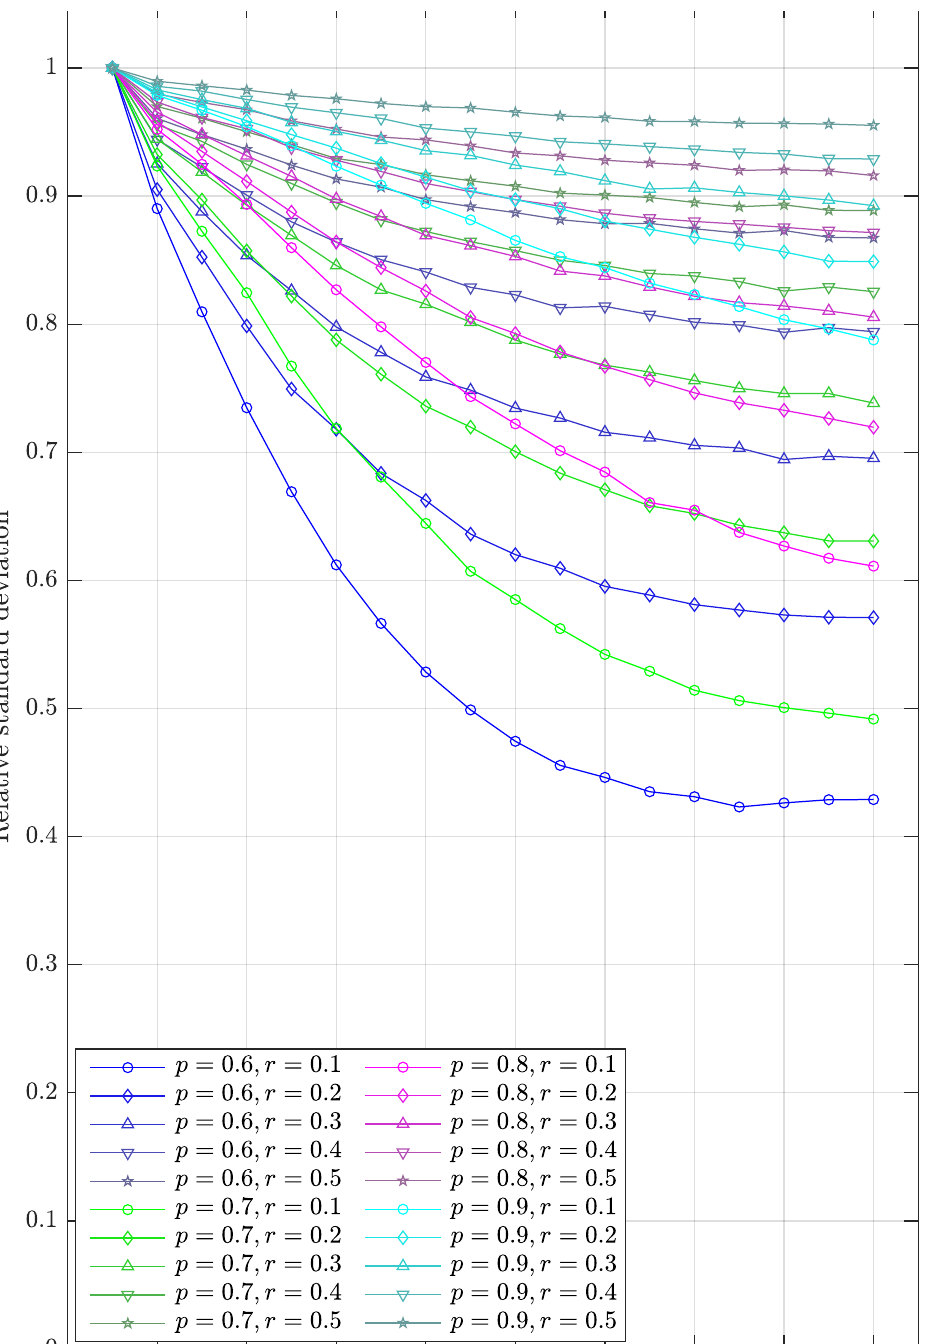
Figure 10. Relative standard deviation (heteroskedastic rms over homoskedastic rms) of the curvature κ for p T = 50,GeV/ c , λ = π /4 and all 20 combinations of p and r in the range 3 ≤ n ≤